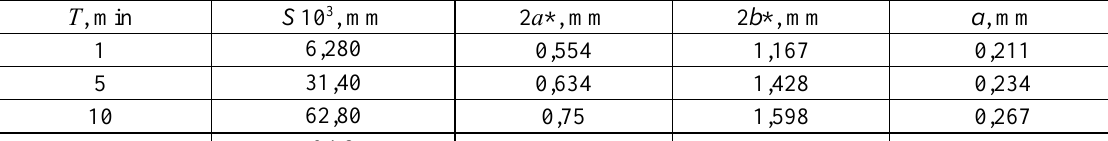
The results of the test of cast iron midrange 20 (Friction pair 1: Cast iron SC 20 - steel 40X hardened)